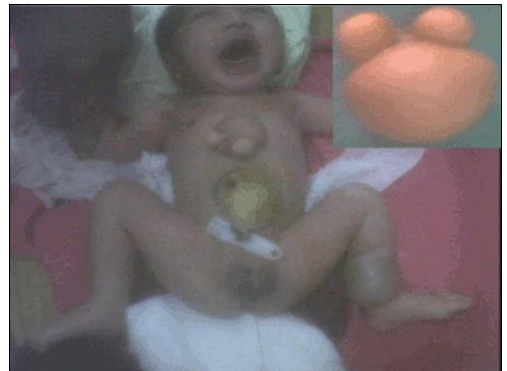
Figure 1: Neonate with omphalocele major, teratoma and hamartoma of left leg and inset showing separated mass, later on diagnosed as